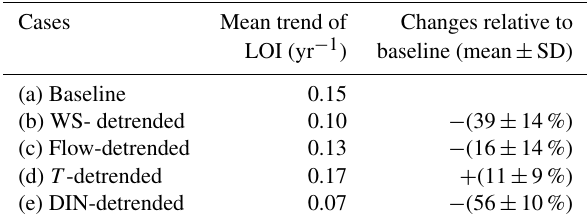
Table 1. Long-term trends in the fitted LOI on average for the se- lected regression cases with R 2 > 0 . 6 (baseline) and for the sensitive experiments with respect to the effects of wind speeds (b), freshwa- ter discharges (c), water temperature (d), and surface DIN concen- trations